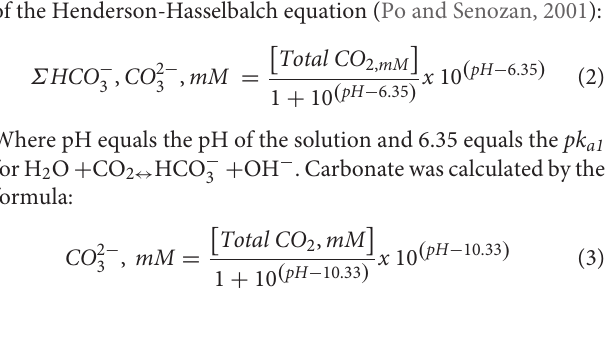
TABLE 1 | Alkalinity as HCO − 3 equivalents by gas chromatography and titration. Gas